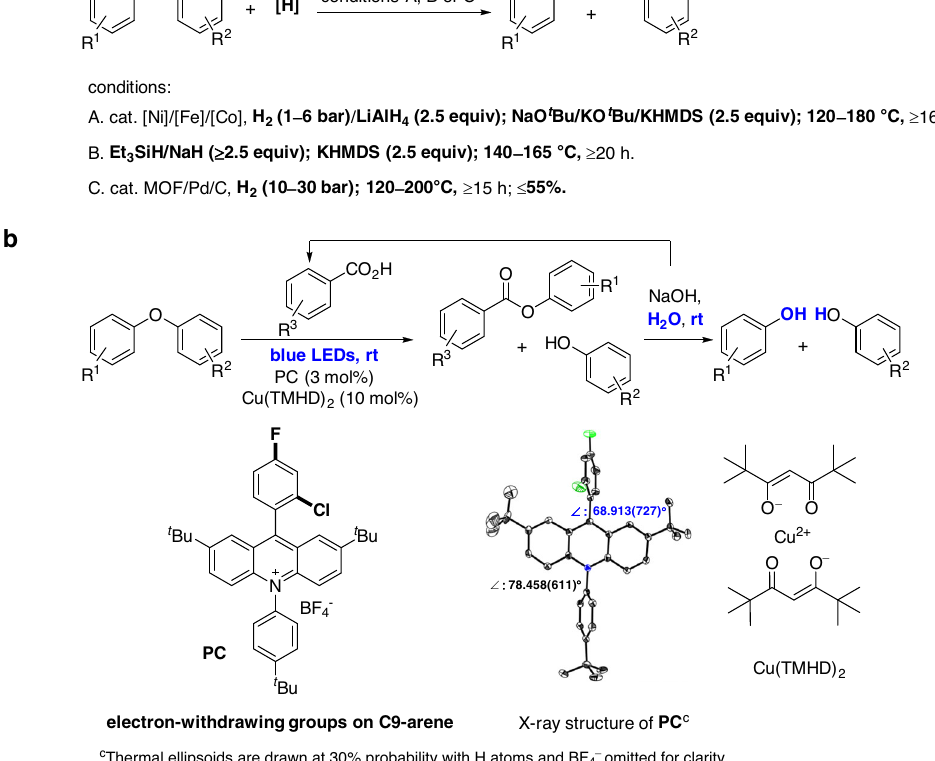
• (cid:129) (cid:129) application to the model of 4-O-5 lignin linkages rt two molecules of phenols